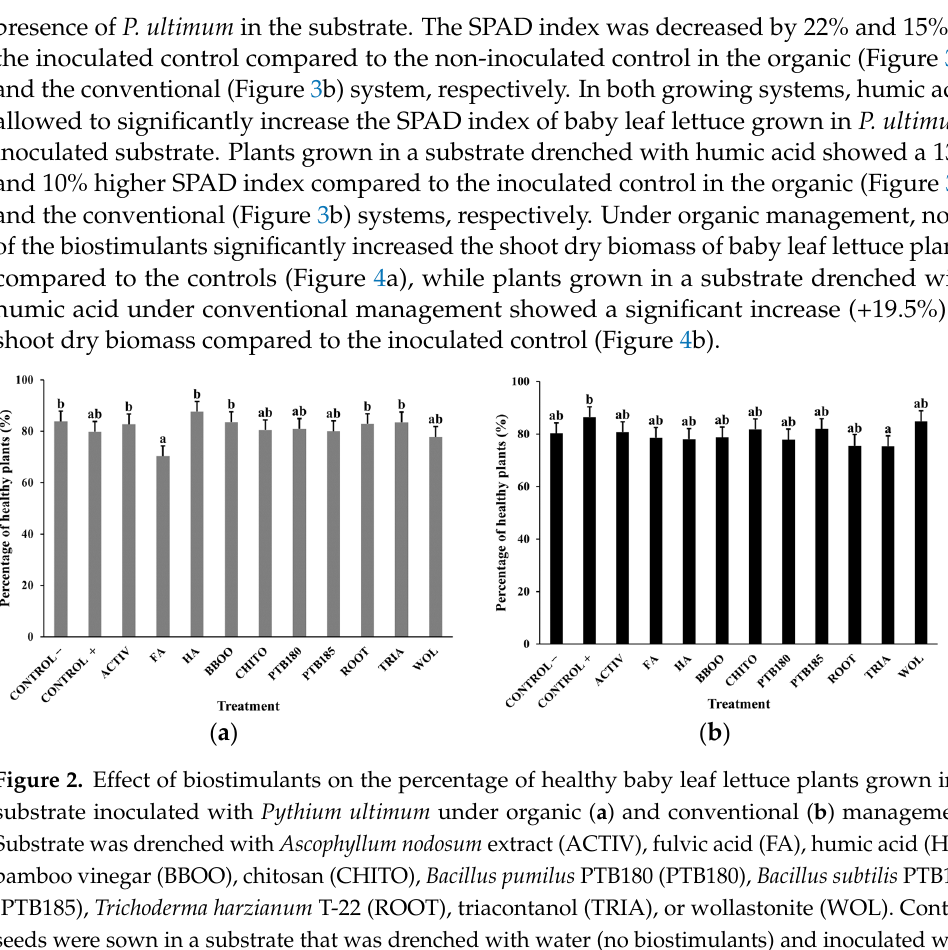
( b ) Figure 1. Effect of biostimulants on the germination rate of baby leaf lettuce seeds sown in a sub ‐ strate inoculated with Pythium ultimum under organic ( a ) and conventional ( b ) management. Sub ‐ strate was drenched with Ascophyllum nodosum extract (ACTIV), fulvic acid (FA), humic acid (HA), bamboo vinegar (BBOO), chitosan (CHITO), Bacillus pumilus PTB180 (PTB180), Bacillus subtilis PTB185 (PTB185), Trichoderma harzianum T ‐ 22 (ROOT), triacontanol (TRIA), or wollastonite (WOL). Control seeds were sown in a substrate that was drenched with water (no biostimulants) and in ‐ oculated with P. ultimum (CONTROL +) or non ‐ inoculated with P. ultimum (CONTROL − ). Each value represents the mean of 8 replicates ± standard error. Means sharing a same letter are not sig ‐ nificantly different according to Fisher’s protected LSD test ( p ≤ 0.05). The percentage of healthy plants at harvest was not significantly different between